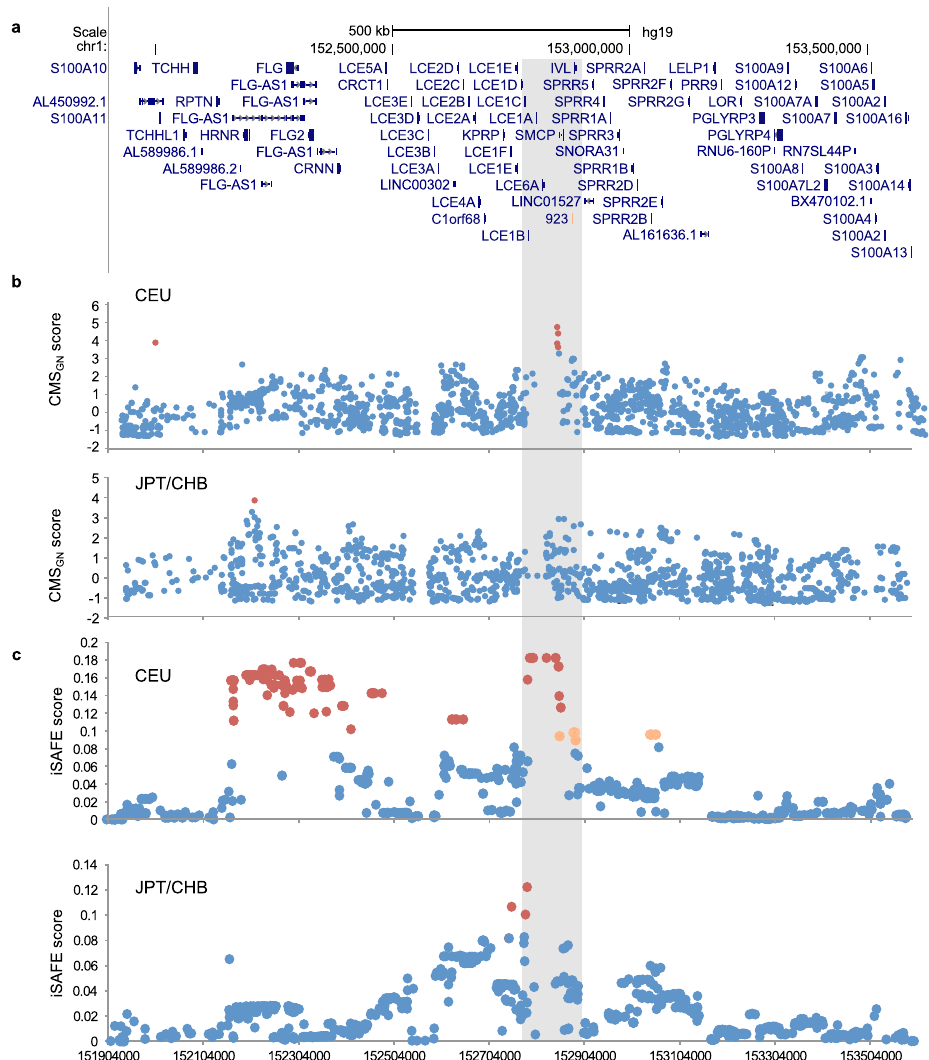
Fig. 1 Human evolution in the skin barrier as evidenced by multiple population-speci fi c signals for positive selection in the epidermal differentiation complex. a Positive selection within the EDC (hg19 [human genome]; chr1:151,904,000-153,593,700) was determined by: b clusters of SNPs with genome-normalized (GN) composite of multiple signals (CMS GN ) score > 2 with a FDR < 0.05, and c SNPs with iSAFE scores > 0.10, all shown as red dots. Orange dots indicate SNPs 0.095<iSAFE score < 0.10. The gray shaded region indicates the region of shared evidence of positive selection in CEU (Utah of European descent) near LCE1B-IVL . CMS scores were previously calculated for 1KGP HapMap II SNPs in CEU and JPT/CHB (Japanese in Tokyo, Japan and Han Chinese in Beijing) populations and iSAFE scores were calculated for 1KGP Phase 3 SNPs in CEU and JPT/CHB. Here, 923 enhancer is shown as orange bar in panel ( a ). kb,